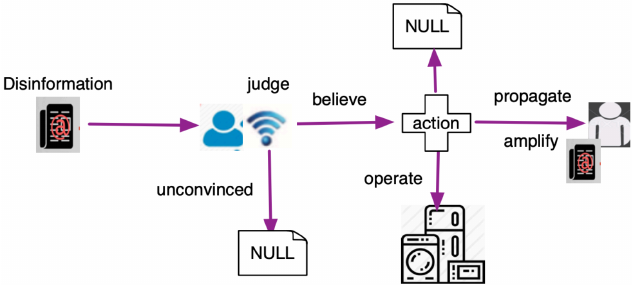
Figure 7. User behavior model in